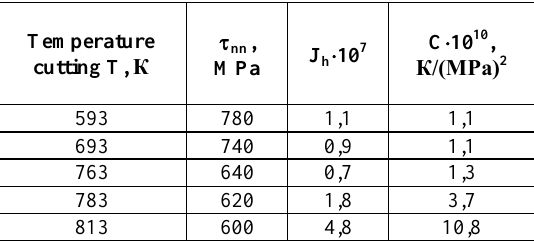
Table 3. Turning of KhN70VMTYUB alloy R18F2K8M cutter; cutting speed V = 3 − 10 m / min; depth t = 0.5